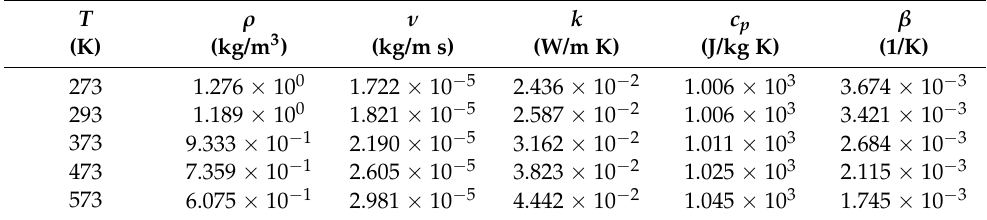
Table 1. Temperature-dependent material properties of air [13].